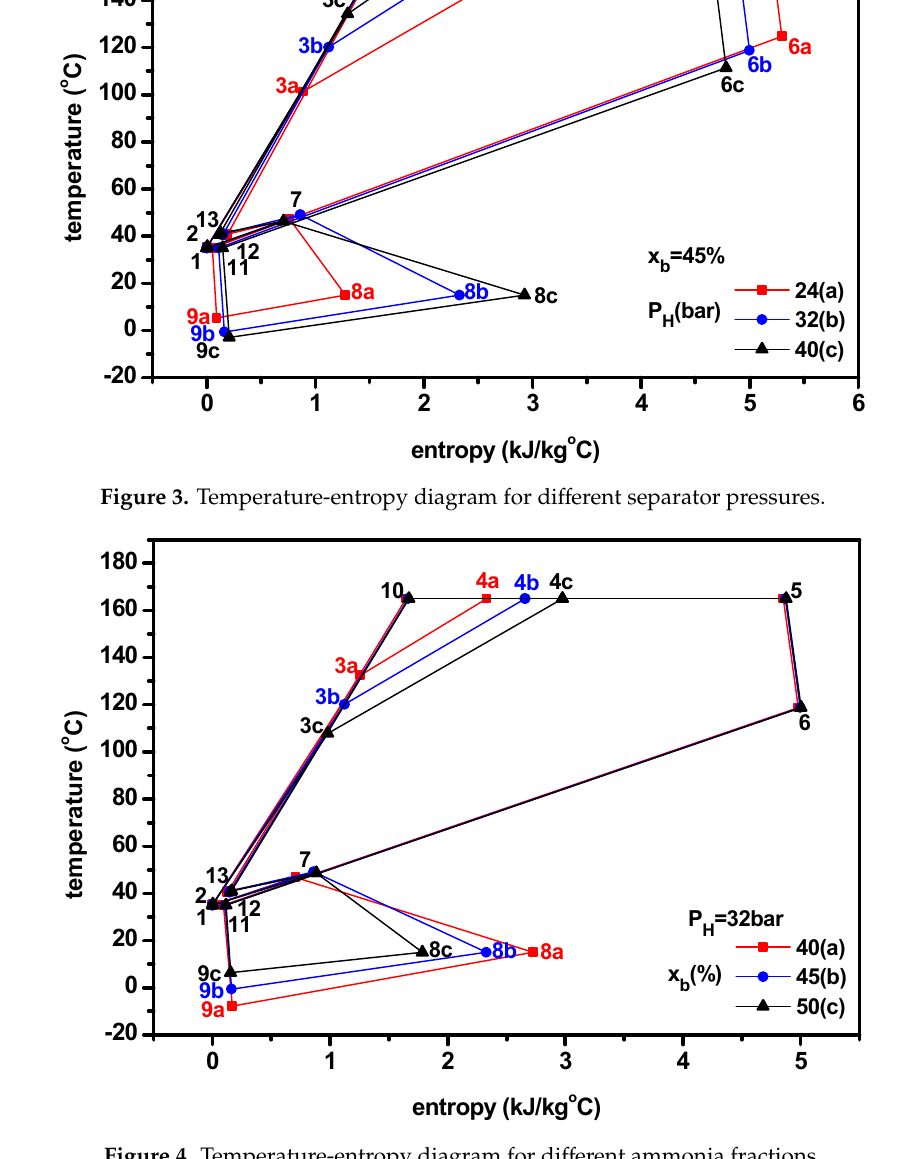
Figure 4. Temperature-entropy diagram for different ammonia fractions.